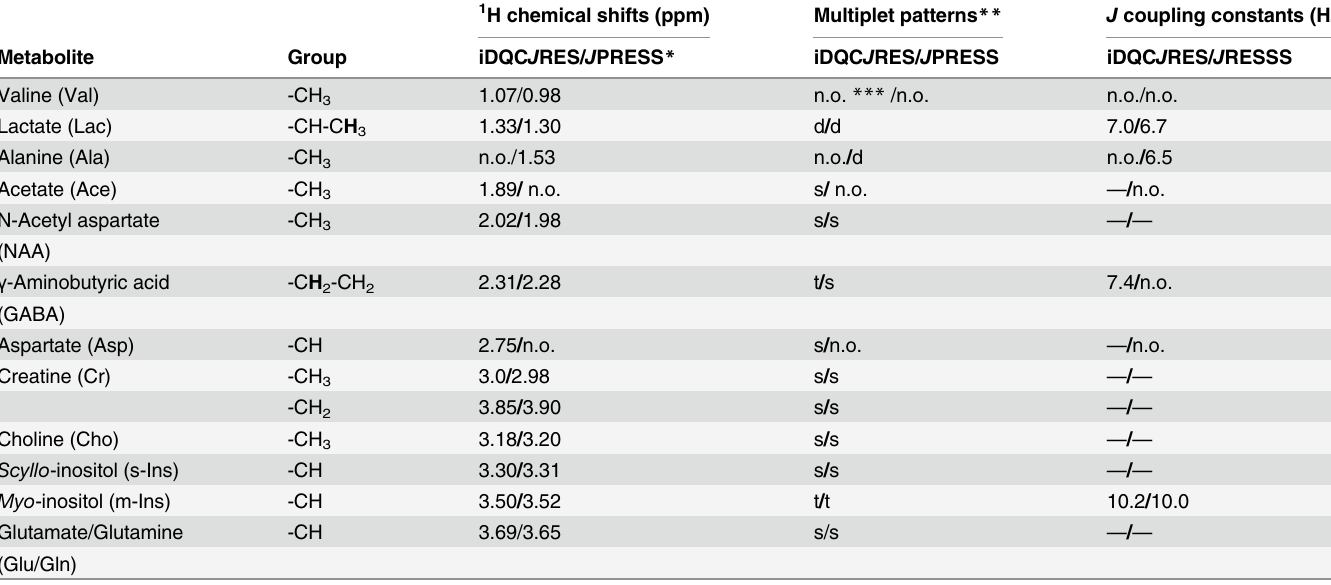
Table 1. Comparison of spectral results of an intact pig brain tissue obtained by localized iDQC J RES and conventional J PRESS methods. 1 H chemical shifts